Question: What visual encoding does this figure use to show its data?
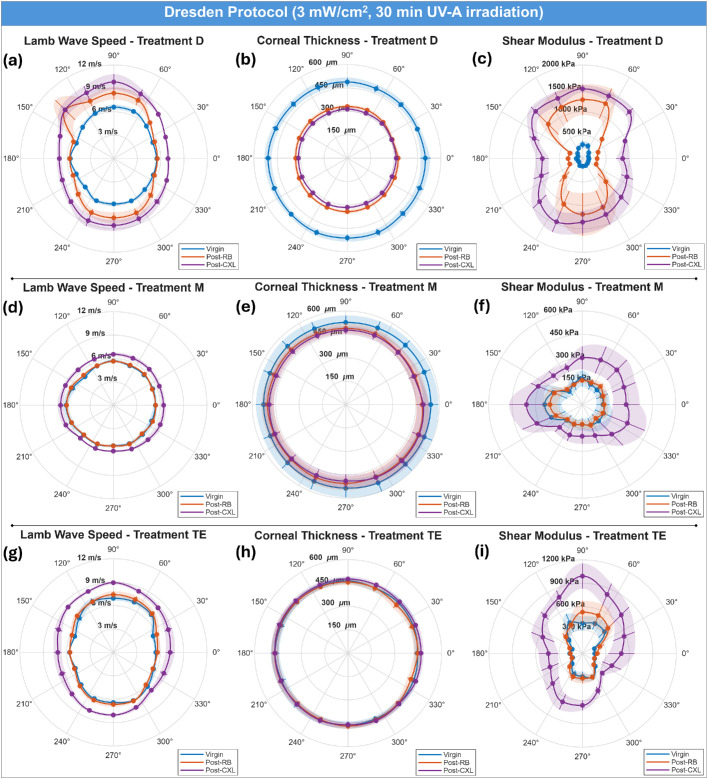
Answer: scatter